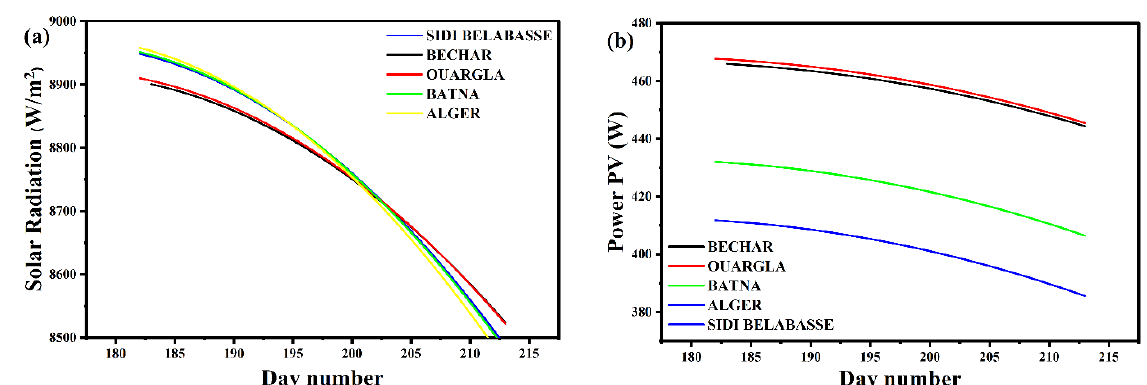
Figure 6. Monthly evolution of ( a ) solar radiation and ( b ) power PV at different sites in Algeria (July 2022).